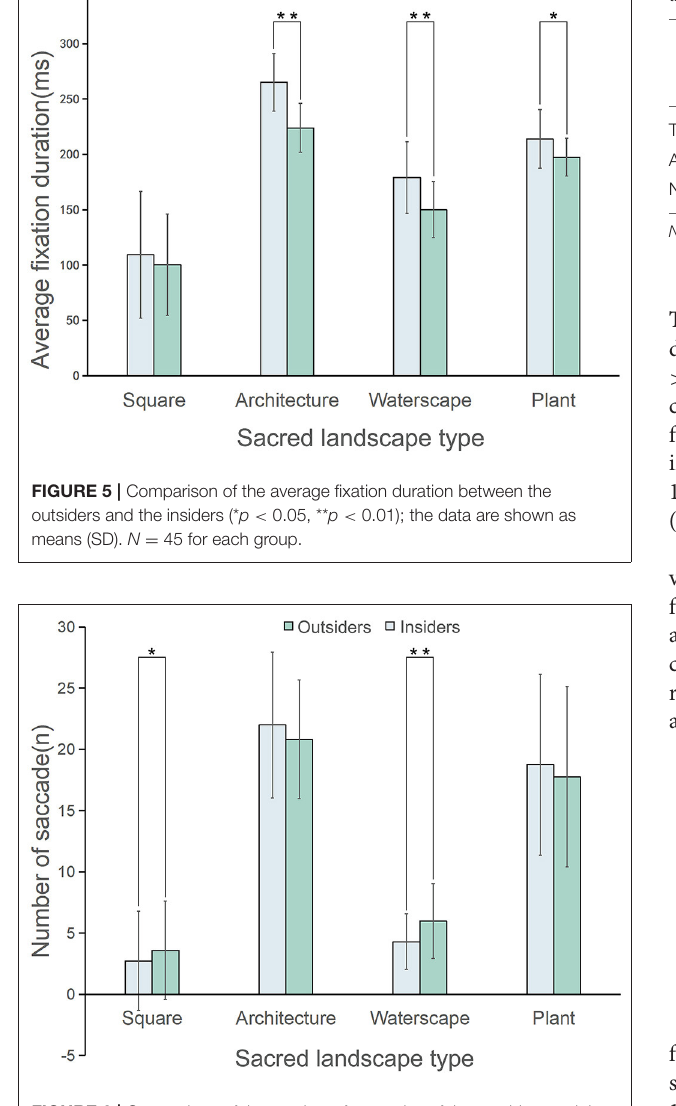
FIGURE 6 | Comparison of the number of saccades of the outsiders and the insiders (* p < 0.05, ** p < 0.01); the data are shown as means (SD). N = 45 for each group.